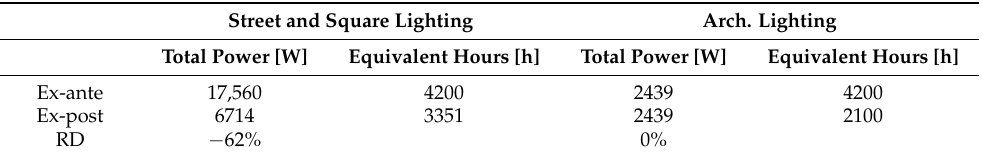
Table 8. Total installed power and equivalent hours of use of the ex-ante and ex-post installations for the street lighting system and the square lighting system and for the architectural lighting